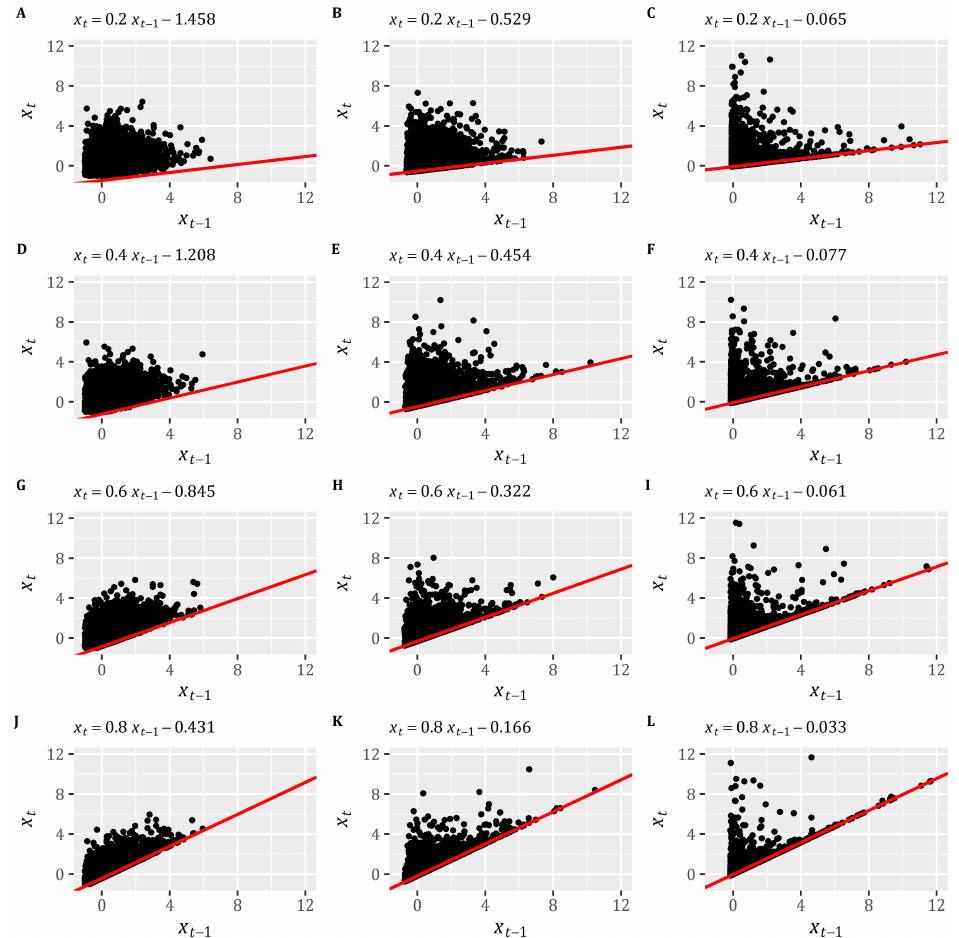
Figure 3. Scatter plots depicting the simulated (using the TF model, i.e., the autoregressive model of order 1 (AR(1))- P III) lag-1 dependence pattern among consecutive time steps (i.e., pair values ( • )